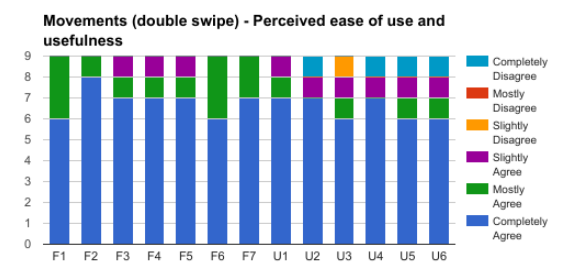
Fig. 12. T5 Luminosity - Perceived ease of use and usefulness.